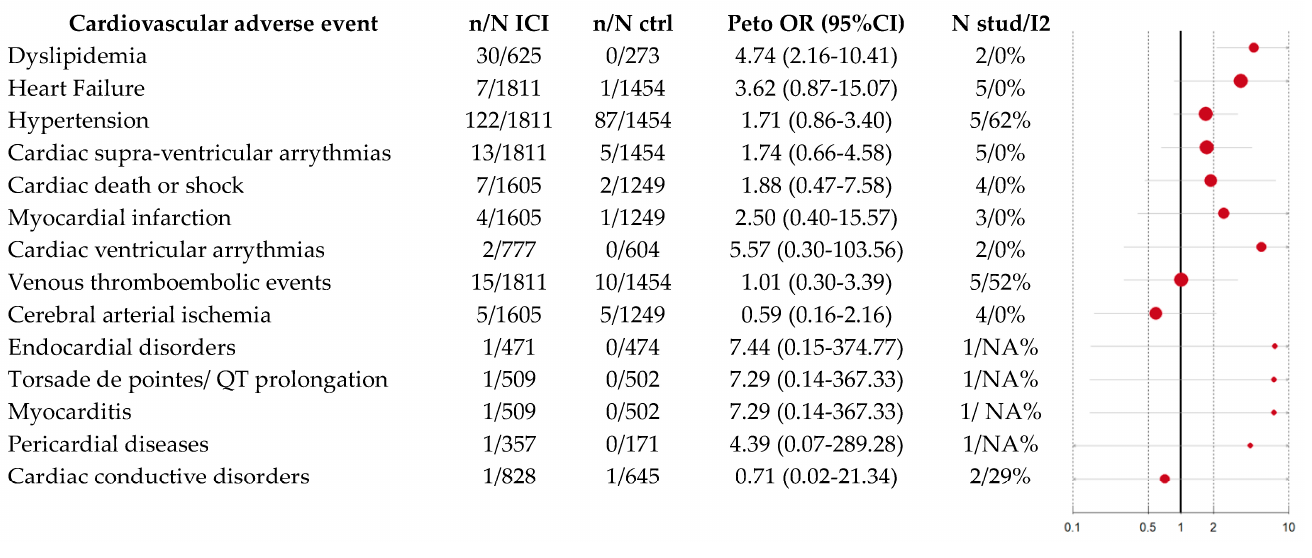
Figure 2. Risk of CVAEs for MM treated with ICI. The line represents the confidence interval and the size of the circle/dot represents the strength of the association (i.e., peto OR). Table 2. Comparison of CVAEs for MM patients versus patients with other